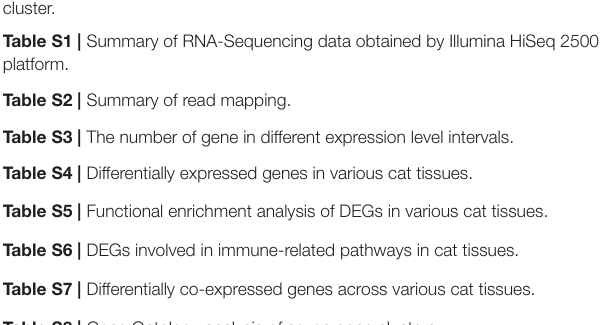
Figure S1 | Agarose gel electrophoresis of PCR amplicons after nested amplification of Toxoplasma gondii B1 gene-specific fragment from cat tissue